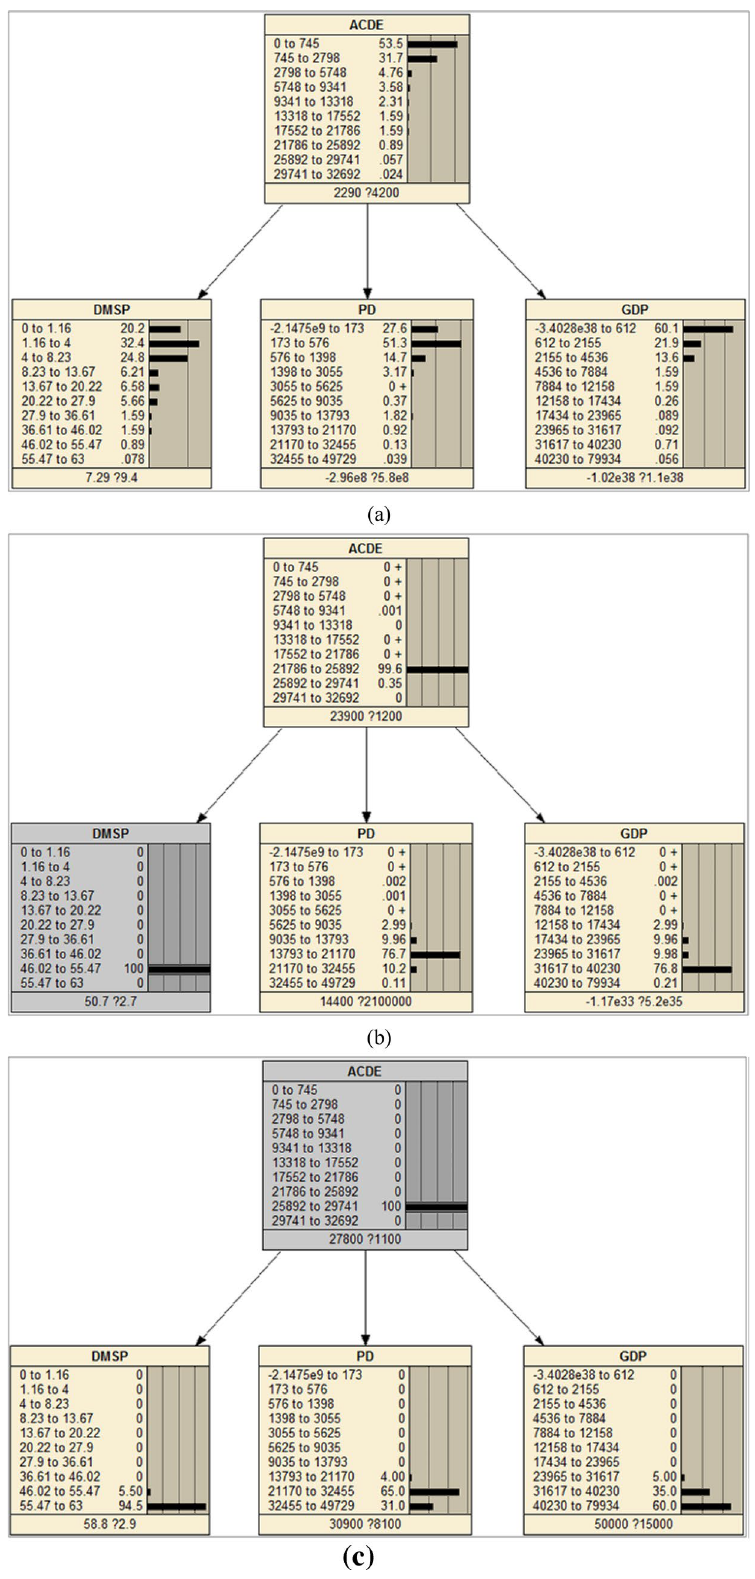
Figure 10. The Naïve Bayesian Networks and the CPTs of the nodes. ( a ) CPTs when learning the network, ( b ) CPTs when giving an evidence of DMSP, ( c ) CPTs when giving an evidence of ACDE. The figs were generated using the Netica software (Norsys Software Corp, Version 5.02, https:// www. norsys.